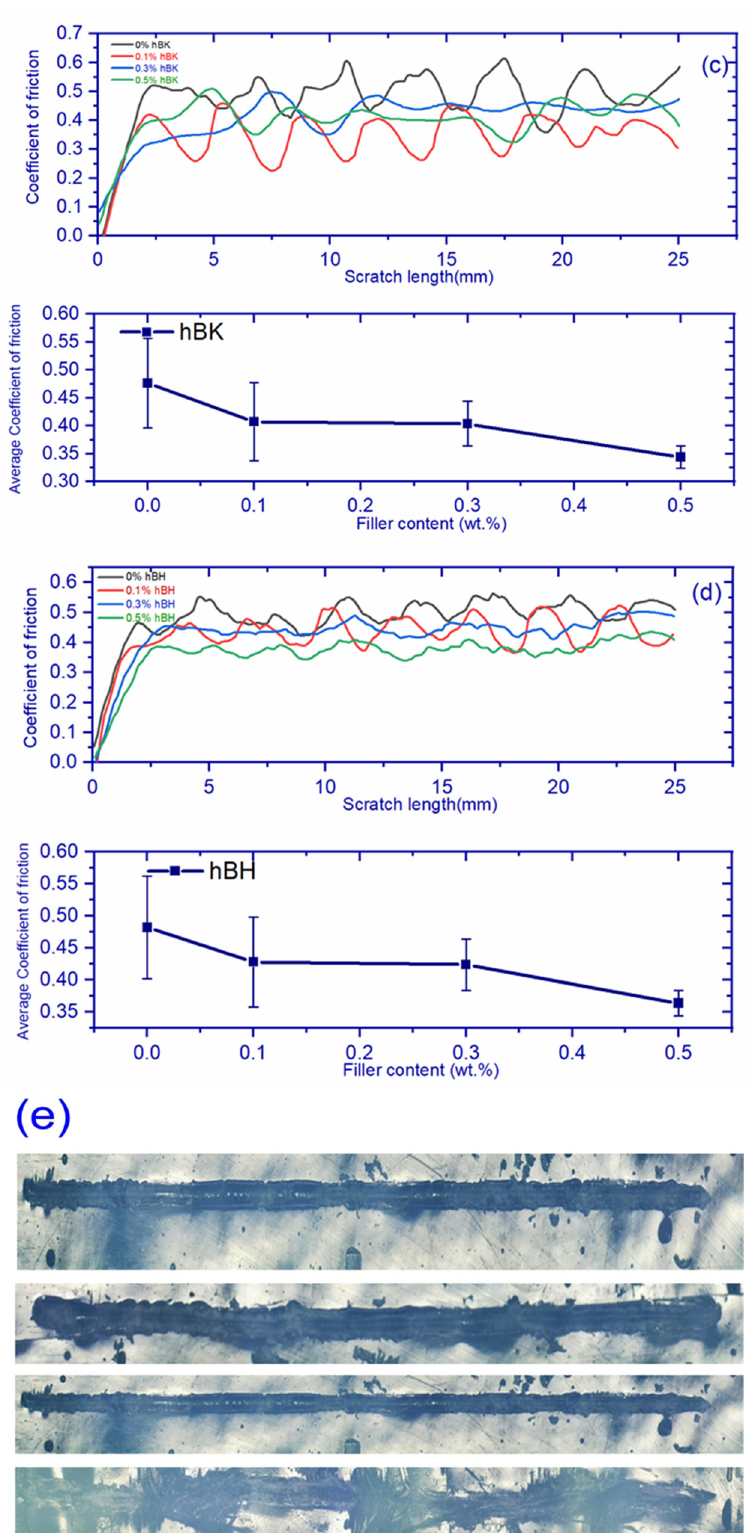
Figure 11. Scratch test of ( a , b ) graphene composites and ( c , d ) hBN composites; ( e ) sample scratch image of graphene composites.